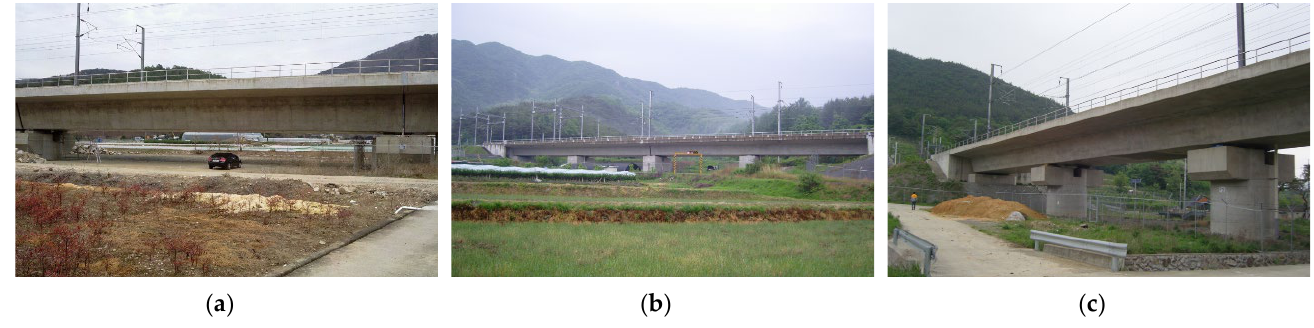
Figure 1. Target bridges: ( a ) Imgi 2nd Bridge; ( b ) Maeaji Bridge; ( c ) Hwalchun Bridge. Table 1. Specifications of the target bridges.